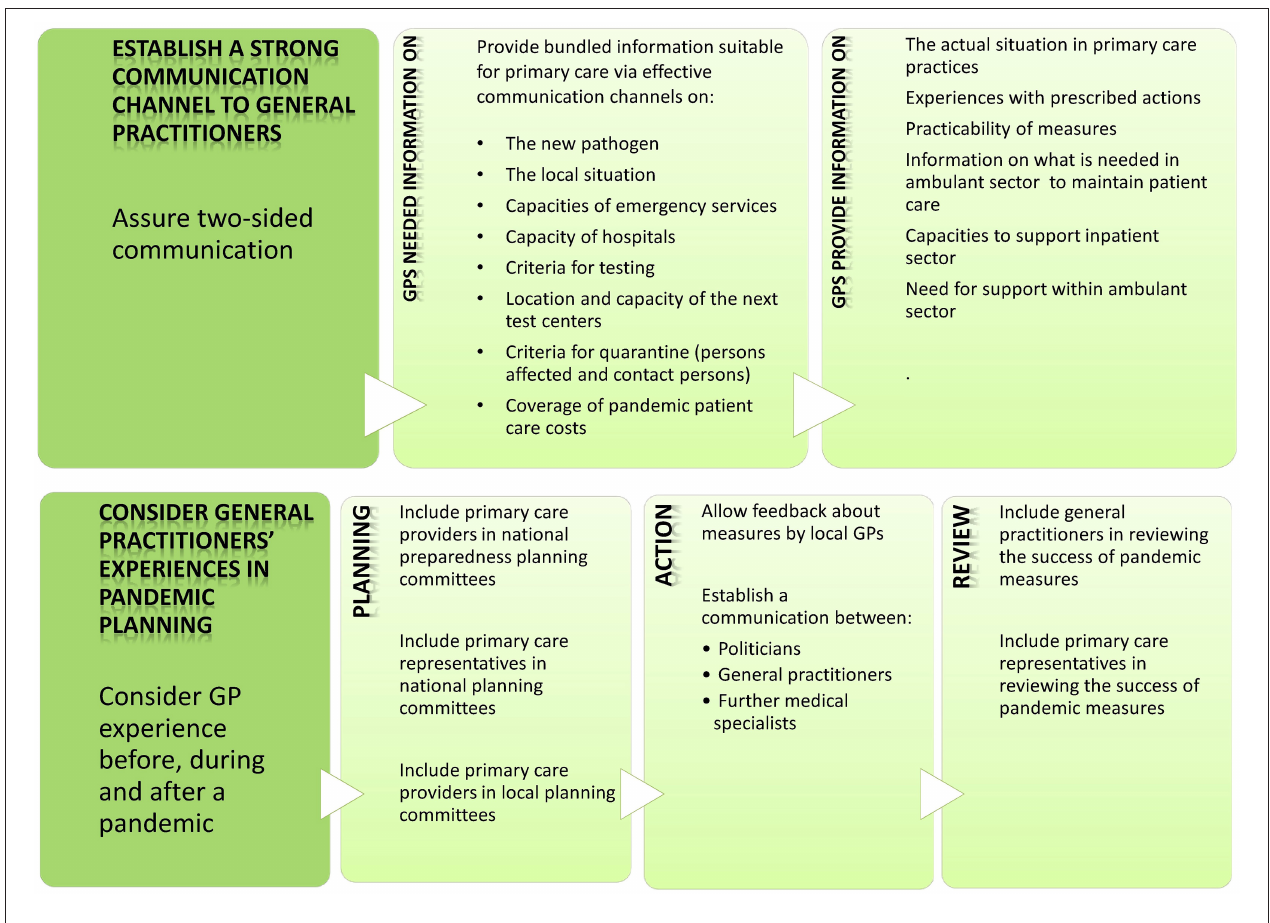
FIGURE 3 | Strategies to face a pandemic—stakeholder